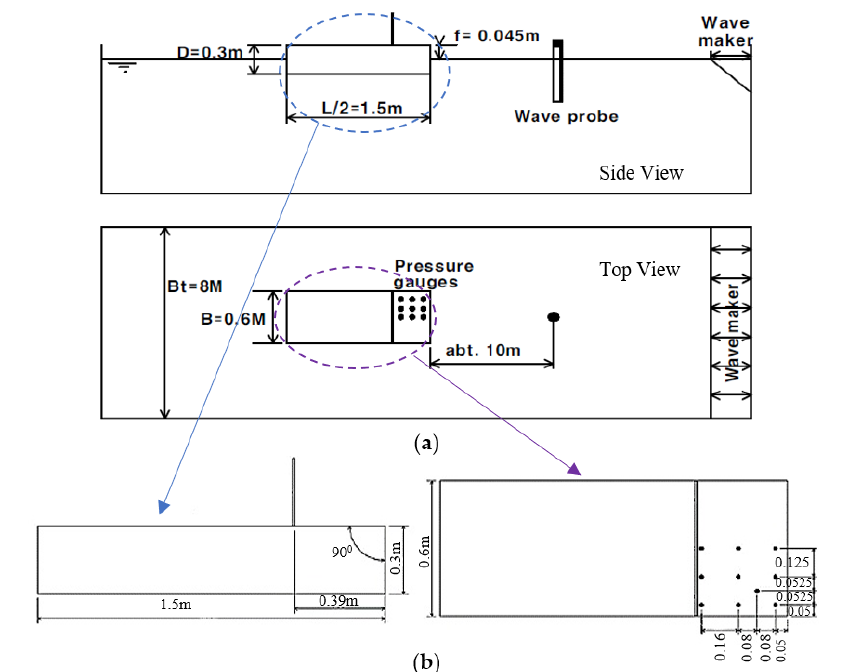
Figure 1. Simulation domain [19]: ( a ) entire domain, including wavemaker. Side view, followed by the top view; ( b ) box-shaped fixed ship model (as marked by dashed circles in ( a )) with a vertical plate acting as deck structure at the bow region (all dimensions in m).